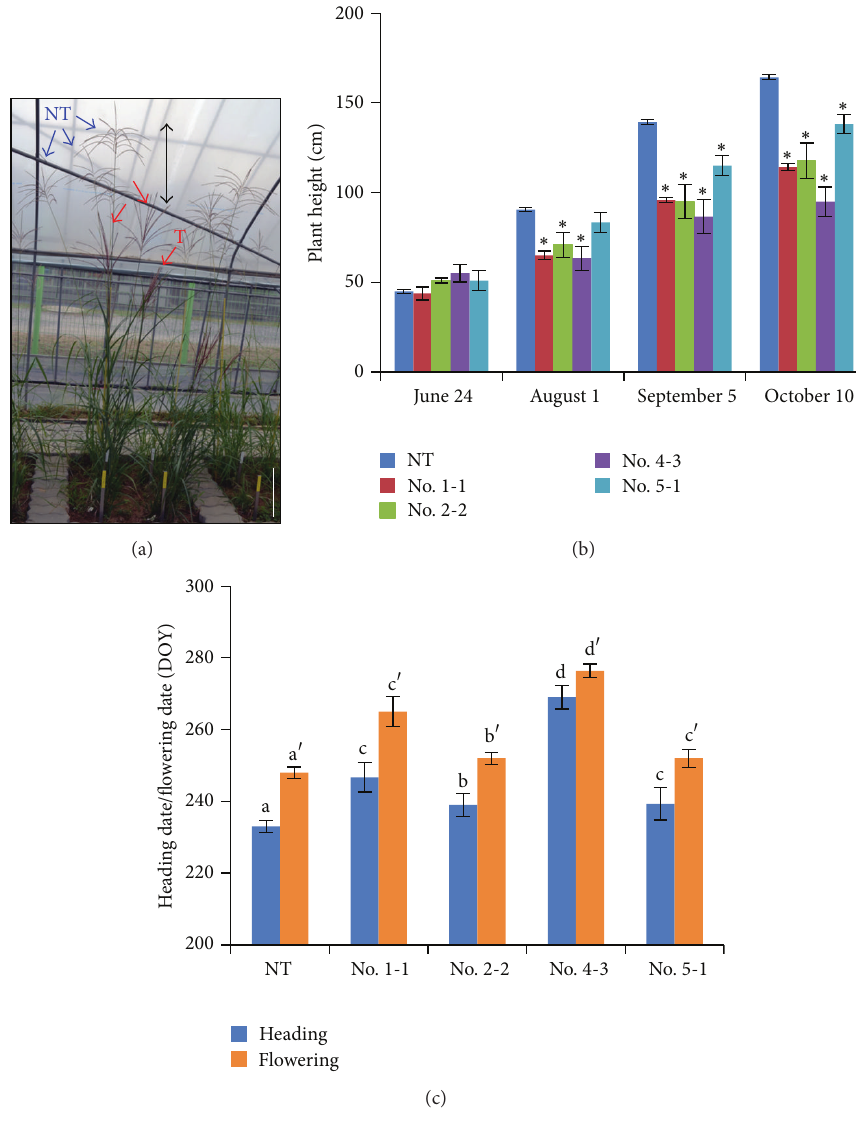
Figure 5: Phenotypic analyses of transgenic M. sinensis plants overexpressing PHYB . (a) Representative picture of nontransformed control plant (NT) and transgenic M. sinensis plants (T). Blue and red arrows represent the control and transgenic plants, respectively. The pictures were taken on DOY (day of year) 273, and the black arrow indicates the difference of plant heights between the control and transgenic plants. Bar: 20 cm. (b) Measurements of plant heights. Error bars indicate standard deviations ( 𝑛 = 3 ). Statistically significant changes compared with NT are indicated by ∗ when 𝑃 < 0.05 , using LSD. (c) Measurements of heading and flowering time. Heading and flowering were observed and measured on date (DOY). Error bars indicate standard deviations ( 𝑛 = 3 ). Means with different letters are significantly different at 𝑃 < 0.05 , using